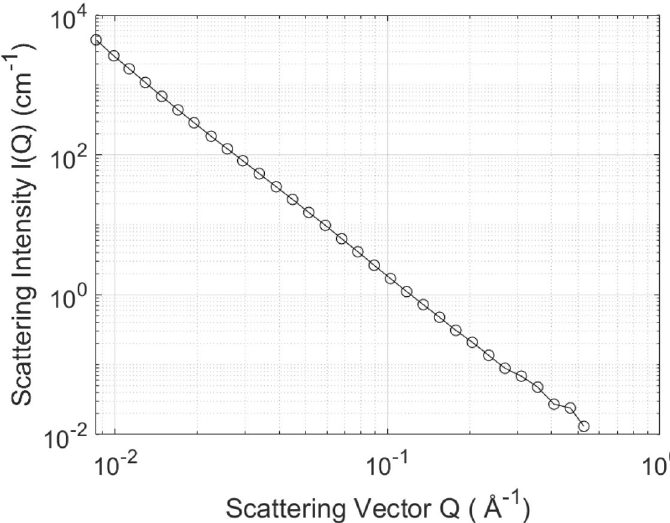
Figure 3. SAXS data for ORS.